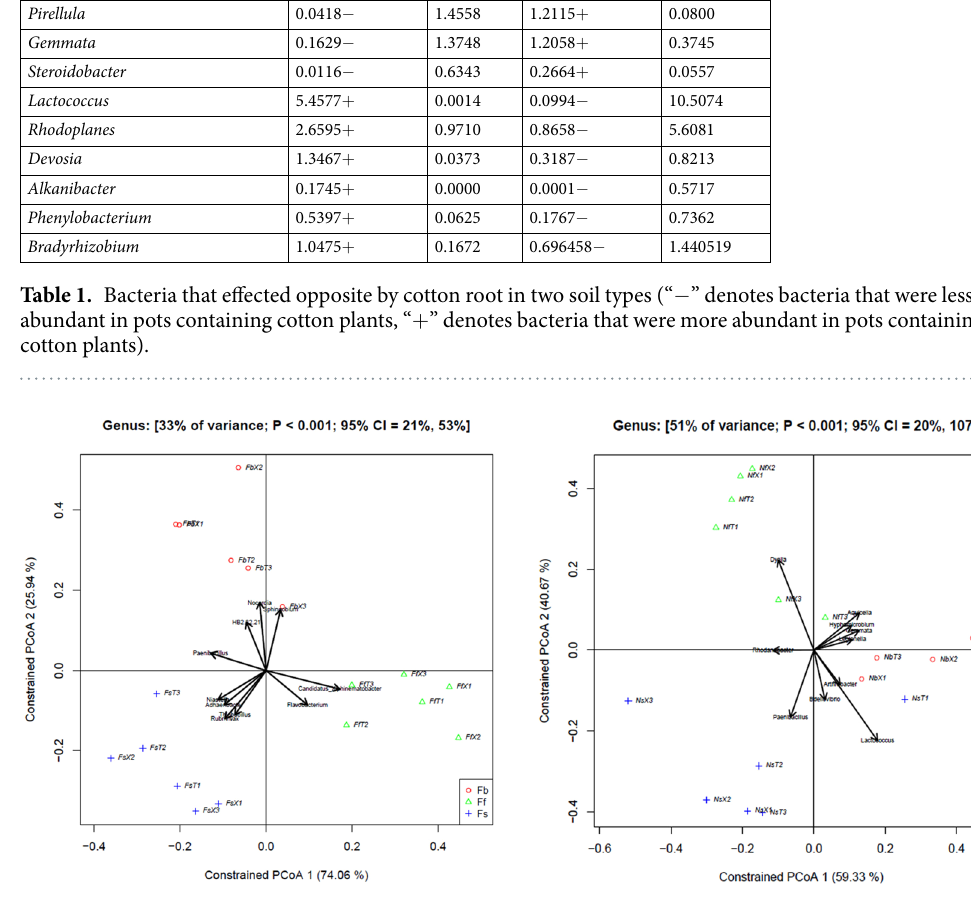
Figure 2. Canonical analysis of principal coordinates analysis (CAP) of influence to rhizosphere bacteria of development stage in two soil types. ( A ) Variation between samples in Bray-Curtis distances constrained by development stage in cotton continuous cropping soil (33% of variance; p < 0.001) and ( B ) Variation between samples in Bray-Curtis distances constrained by development stage in nutrient rich soil (51% of variance; p <